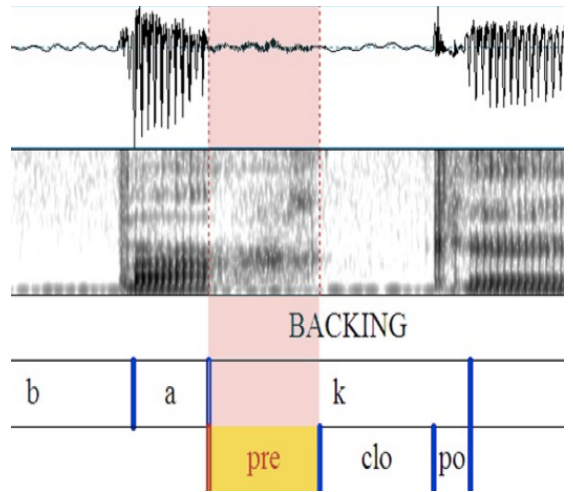
Figure 1: Identi(cid:976)ication of pre-aspiration.